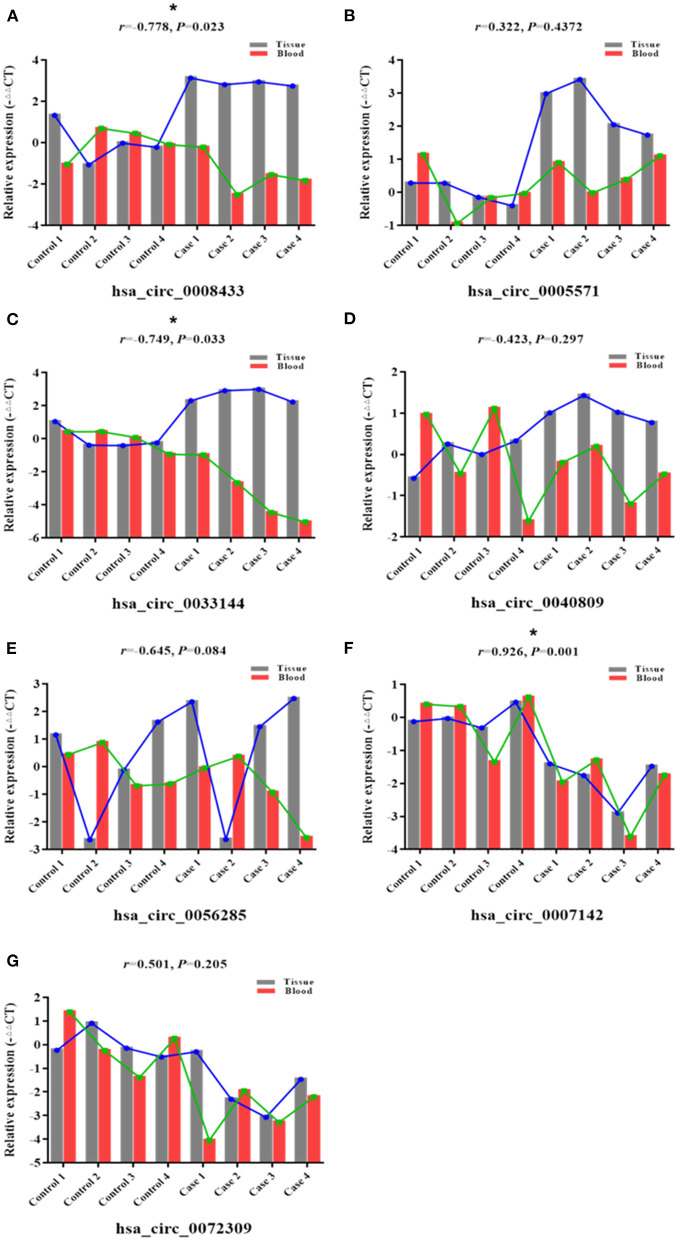
Correlation between specific circRNAs in IA tissue and blood. (A–G) Correlations between 7 selected circRNAs hsa_circ_ (0008433, 0005571, 0033144, 0040809, 0056285, 0007142, 0072309) in each IA and STA sample from tissue and peripheral blood, *P < 0.05.